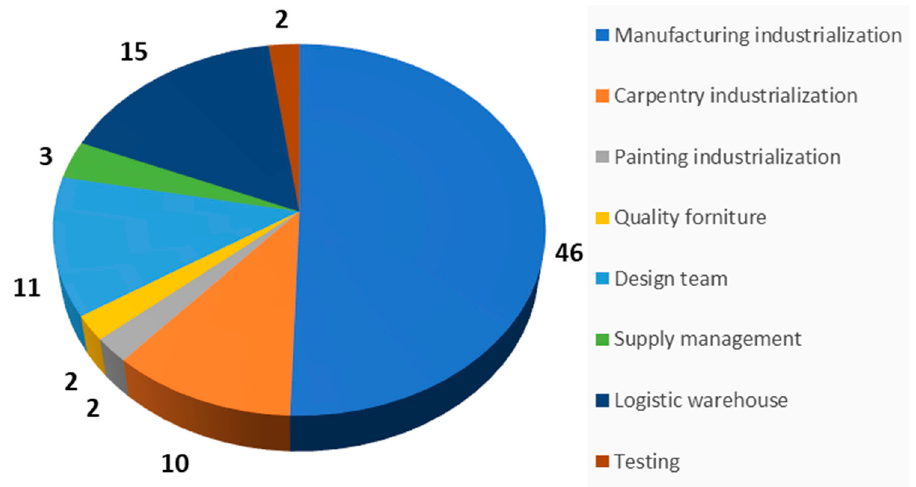
Figure 4. Recommended actions submitted to their respective experts.